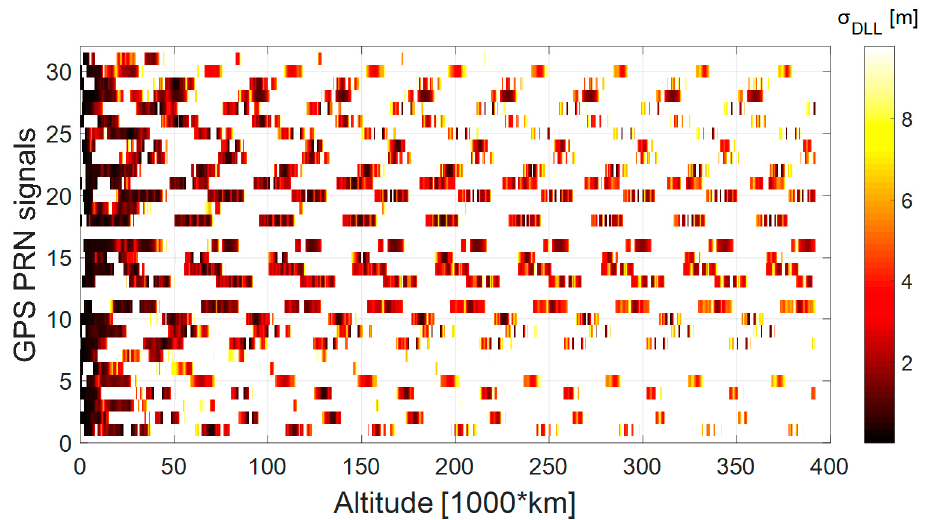
Figure 16. (cid:2026) (cid:3047)(cid:3005)(cid:3013)(cid:3013) , when assuming 3D transmitter patterns. Figure 16. σ tDLL , when assuming 3D transmitter